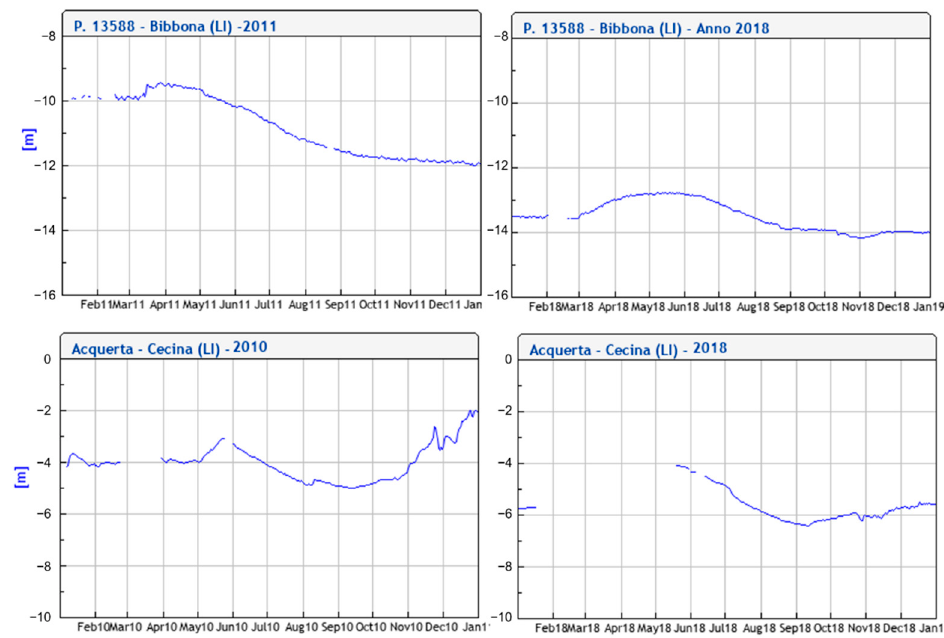
Figure A1. Piezometric levels registered by the Tuscany Region Hydrological Division for the P13588 station in Bibbona (E 1627661, N 4791226) and the “Acquerta” station in Cecina (E 1623732, N 4798039).